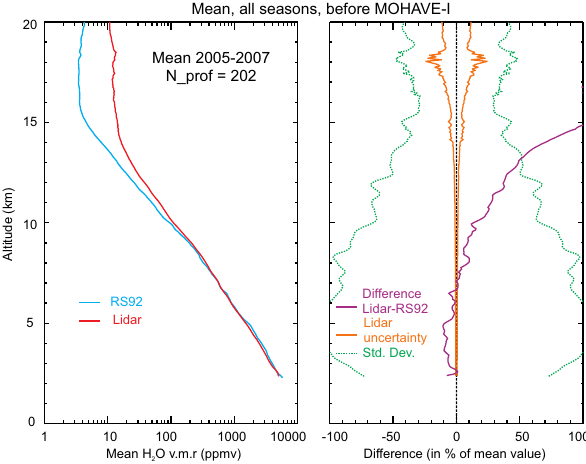
Fig. 7. Comparison of the climatological mixing ratio profiles mea- sured over the period June 2005–October 2007 by the TMW lidar and simultaneous and co-located Vaisala RS92 radiosondes. Left plot: mean profiles. Right plot: mean difference, lidar measurement uncertainty and standard